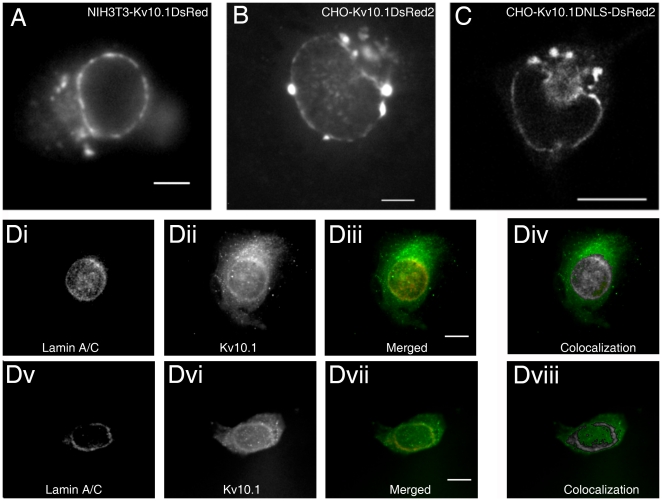
Examples of perinuclear localization of KV10.1.A. NIH3T3 cells transfected with KV10.1-DsRed (wide field epifluorescence image of living cell, 40x/0.75 Zeiss Achroplan water immersion objective). B. CHO cell transfected with KV10.1-DsRed2 (wide field epifluorescence image of living cell, 63x/0.9 Zeiss Achroplan water immersion objective). Scale bars: 5 µm. C. Confocal image showing perinuclear localization of EGFP-KV10.1DNLS (devoid of nuclear localization signal) in a living CHO cell (Zeiss LSM510Meta, Plan-Neofluar 40x/1.3 Oil DIC objective; scale bar: 10 µm). D. Two examples of co-localization of KV10.1 with lamin A/C. HeLa cells fixed with methanol were stained with goat anti human lamin A/C (Di, Dv; Alexa Fluor 546 donkey anti-goat secondary antibody) and rabbit polyclonal anti-KV10.1 (Dii, Dvi; donkey anti-rabbit FITC conjugated secondary antibody) and antibodies. Diii, Dvii merged images. Div, Dviii, Co-localization display; grayscale intensity indicates colocalization (analyzed using FiJi). Wide field epifluorescence image, 63x Zeiss Plan Apochromat 1.4 oil immersion objective. Scale bar: 10 µm. Gaussian blur (d = 2 pixel) was applied to all the images.